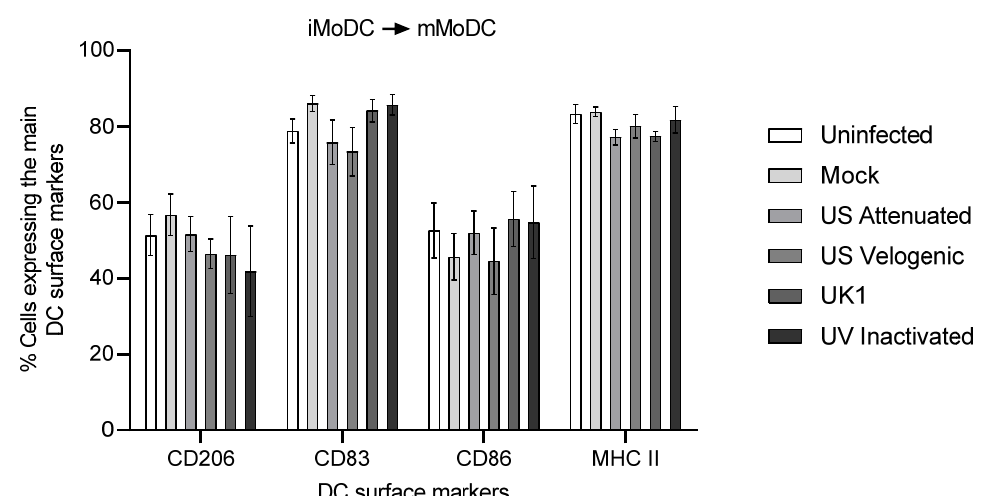
Figure 12. Effect of EAV infection on MoDC activation. Immature MoDC were inoculated at MOI of 5 with different strains of live and UV inactivated EAV. Cells were incubated for 2 h prior to the addition of the maturation cocktail. Cultures were incubated further for 16 h, after which cells were harvested and stained to assess phenotype by flow cytometry. For the different treatments, the same number of events (10,000) were analyzed by flow cytometry. Upon activation, there were no significant differences in the phenotype of MoDC infected with different EAV strains. Results were represented as the percentage surface marker expression ± SEM ( n = 6). A 2-way ANOVA with